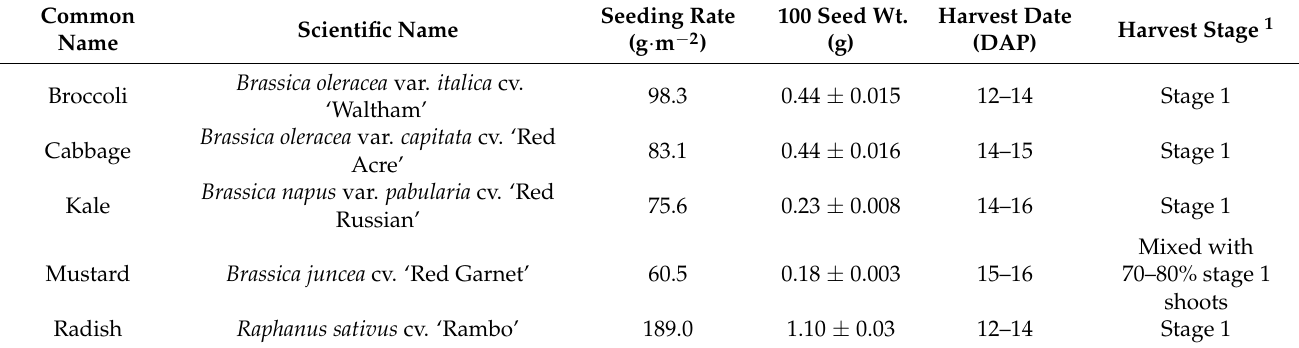
Table 1. Common name, scientific name, seeding rate, 100 seed weight, and harvest date of five microgreens.